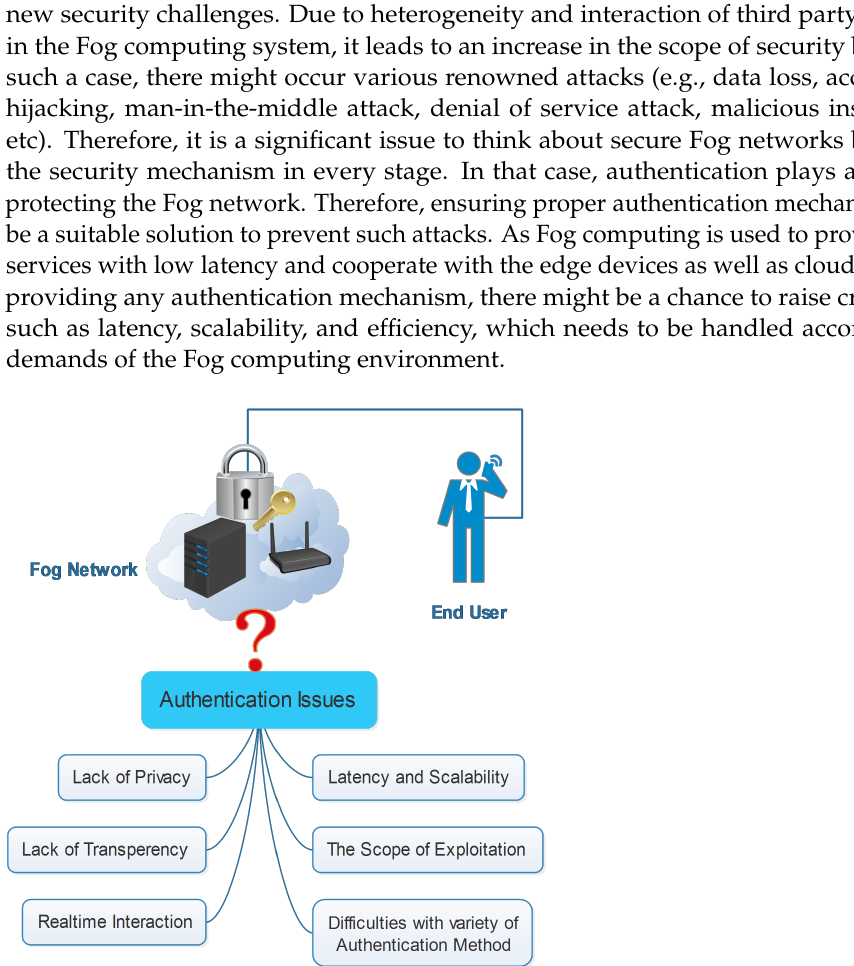
Figure 5. Authentication issues arise in Fog